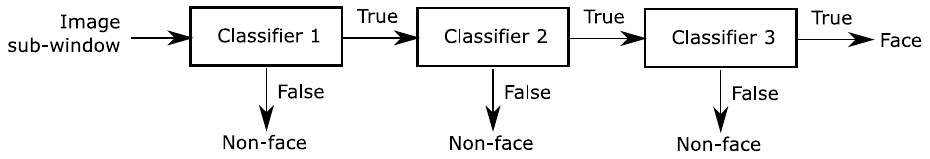
Figure 5. Illustration diagram of the attentional